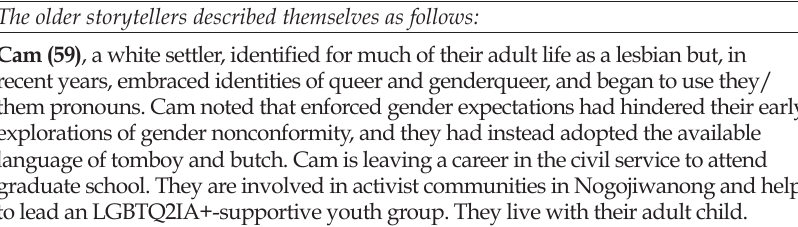
Table 1 . Older storytellers: Diverse (later)